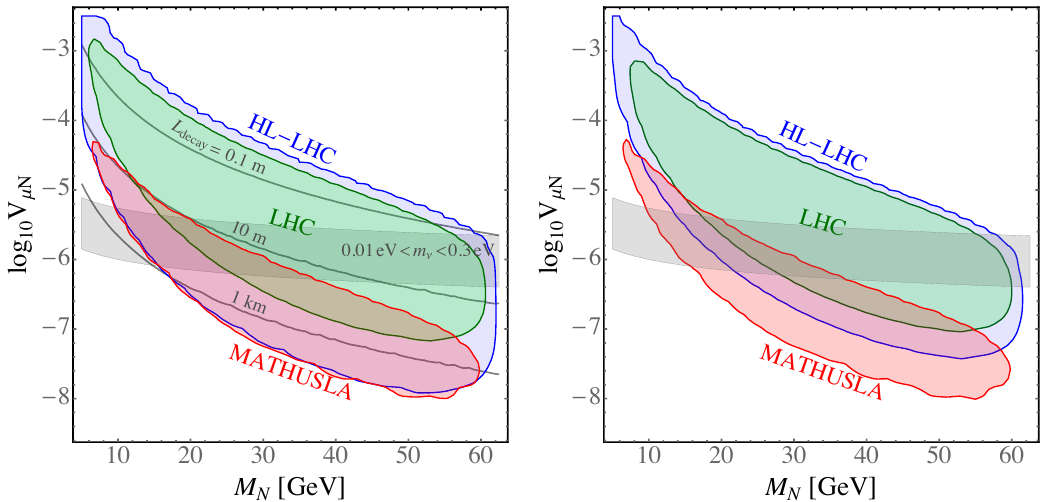
Figure 7 . Excluded regions in the ( M N ; V (cid:22)N ) parameter space at 95% C.L. assuming no obser- vation of a single displaced vertex for the 100 fb (cid:0) 1 LHC (green), the 3000 fb (cid:0) 1 HL-LHC (blue) and the MATHUSLA option at HL-LHC (red). The left plot is in the optimistic view assuming no background after selection criteria whereas the right plot is in the pessimistic view where the upper limit on the background rate from the non-observation at 20.5 fb (cid:0) 1 is scaled to the di(cid:11)erent luminosities. The grey band indicates the parameter region where a light neutrino mass in the interesting range is generated, 0 : 01 eV < m (cid:23) = V 2 m N < 0 : 3 eV. The red indicate proper decay (cid:22)N lengths of the RH